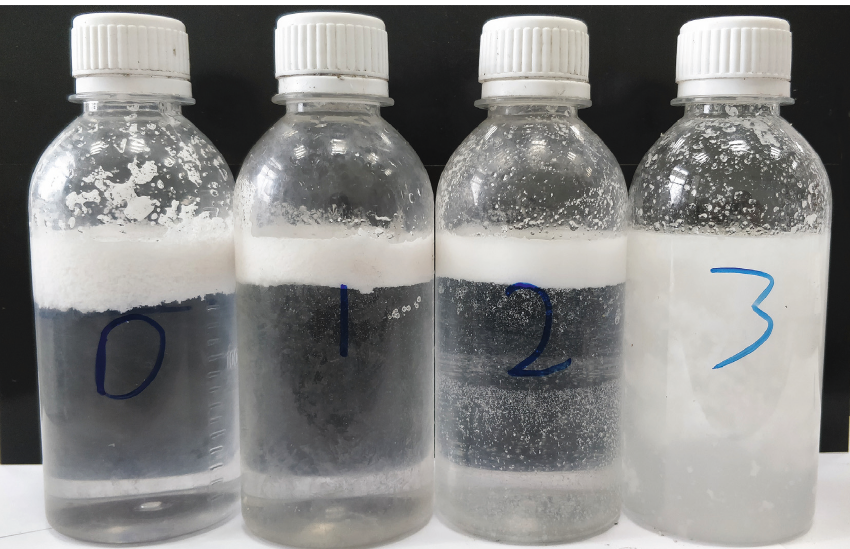
Figure 2: Dispersion stability of unmodified and modified TPR in water (0: unmodified TPR; 1: TPR modified by KH550; 2: TPR modified by KH560; 3: TPR modified by KH570).